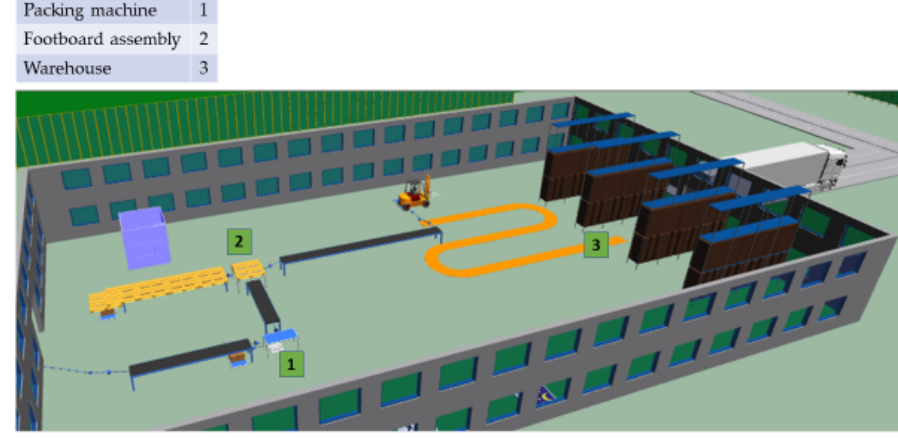
Figure 6. Packaging Area, built through Siemens Plant Simulation.